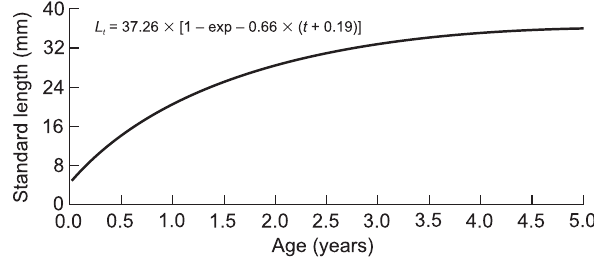
Figure 8. Length growth curve estimated for H. marginatus in Piravevê sub-basin, Ivinhema River Basin.